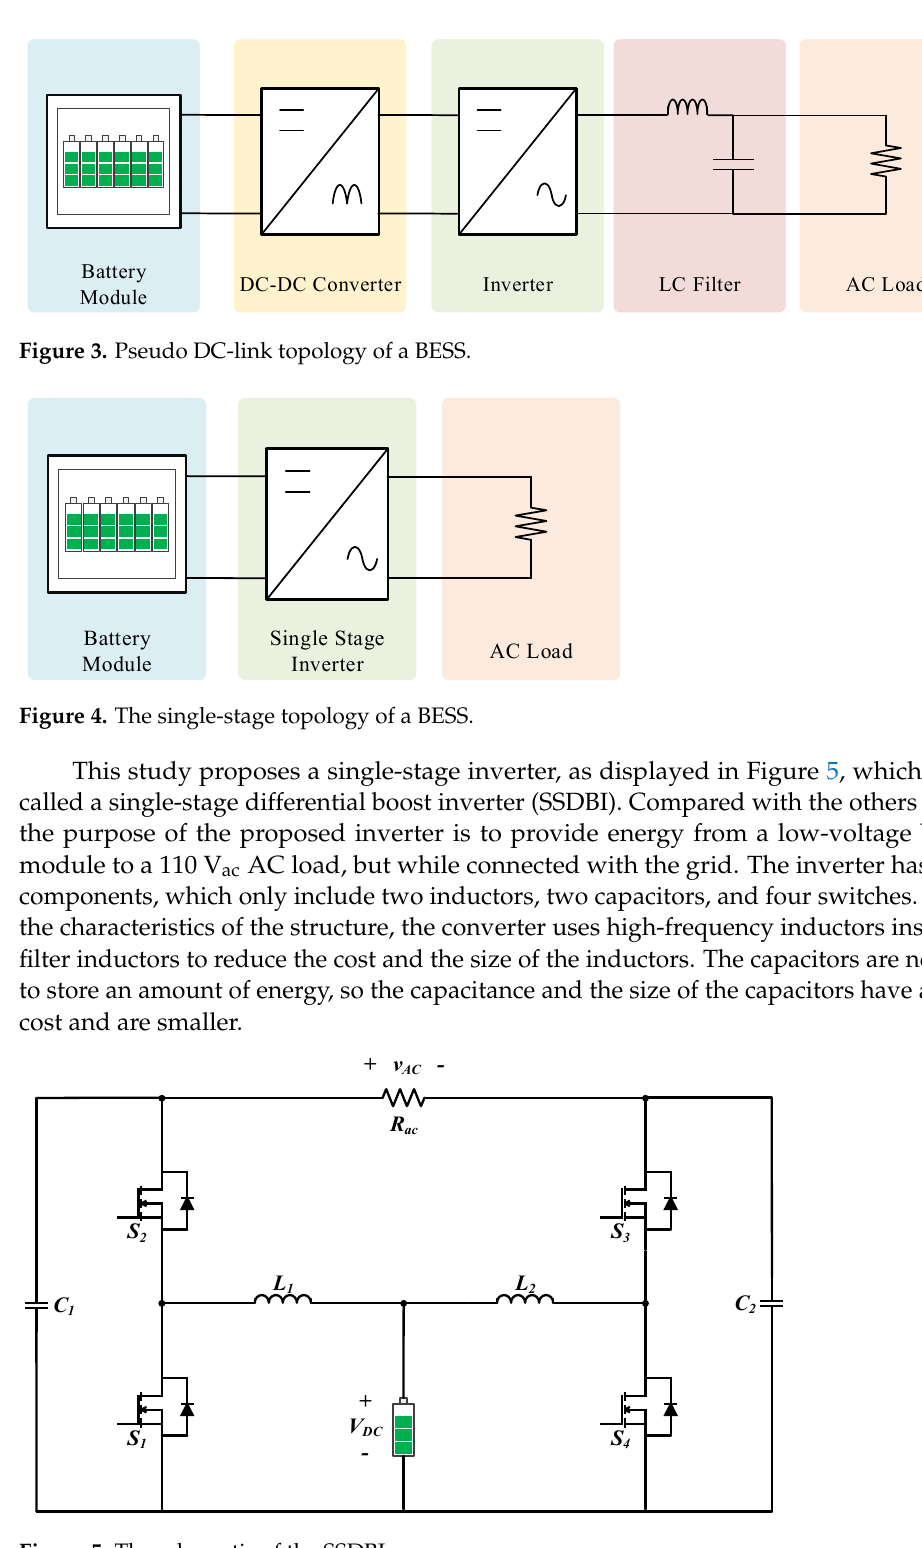
Figure 5. The schematic of the SSDBI.